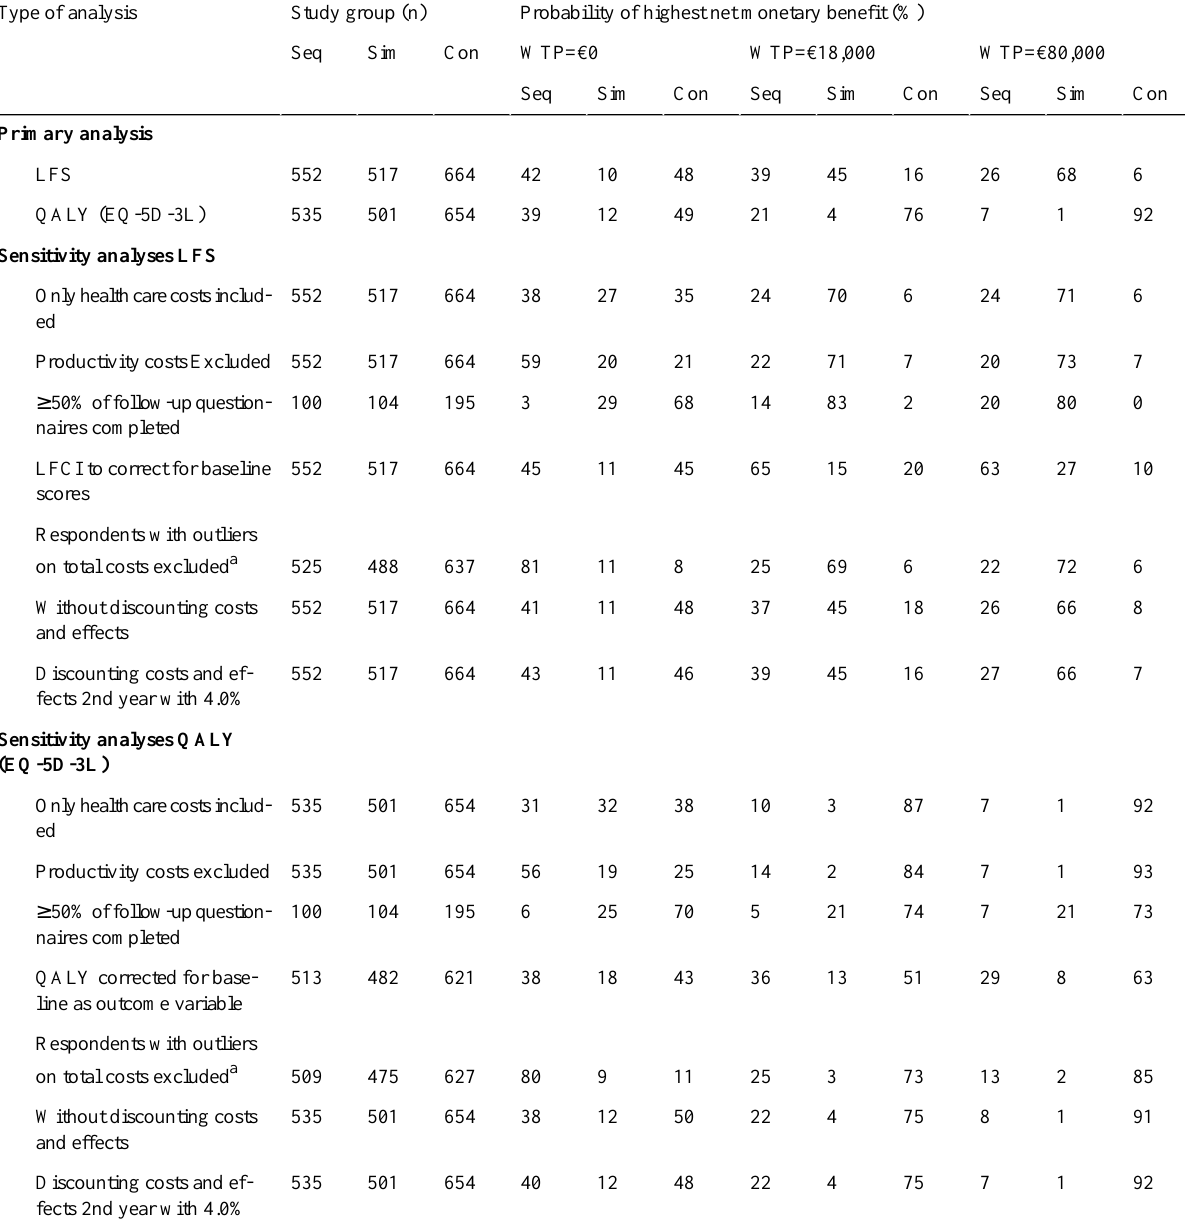
Table 5. Results from cost-effectiveness and cost-utility analyses based on 1000 bootstrap replications for the sequential (seq), simultaneous (sim), and control (con)